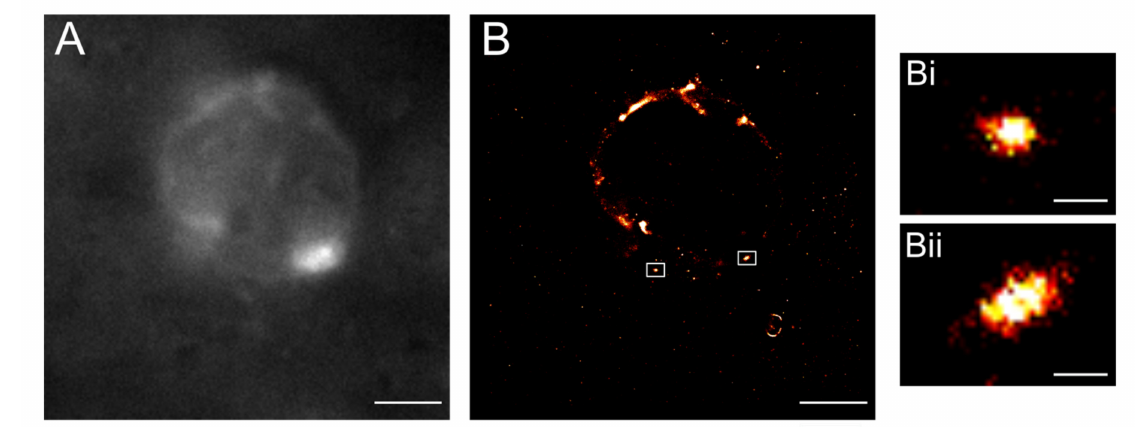
Figure 10. SMLM of miR-21 aggregates in the nuclear area of a carcinoma cell within a human colorectal cancer tissue sample. Smaller blinking events were detected in the cytosolic area as well. ( A ) Widefield and ( B ) super-resolved reconstruction images. Two ROIs are highlighted in white ( Bi , Bii ) showing miR21 aggregates. Scale bars 3 µ m. Insets scale bars 200